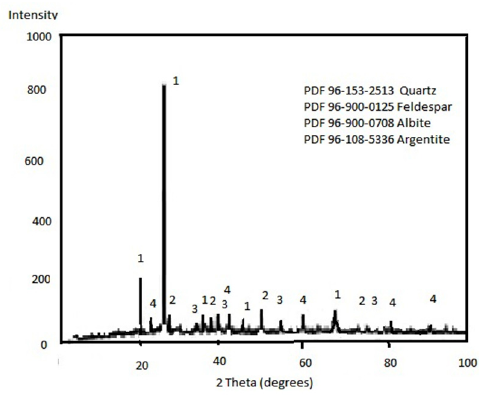
Figure 3. XRD spectrum of the MW from “Velasco” dam.